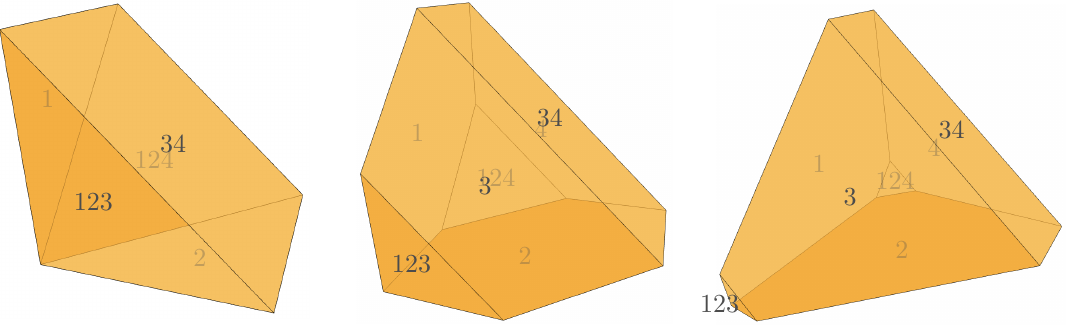
, F , L . Facets are labelled by the edges belonging par par par